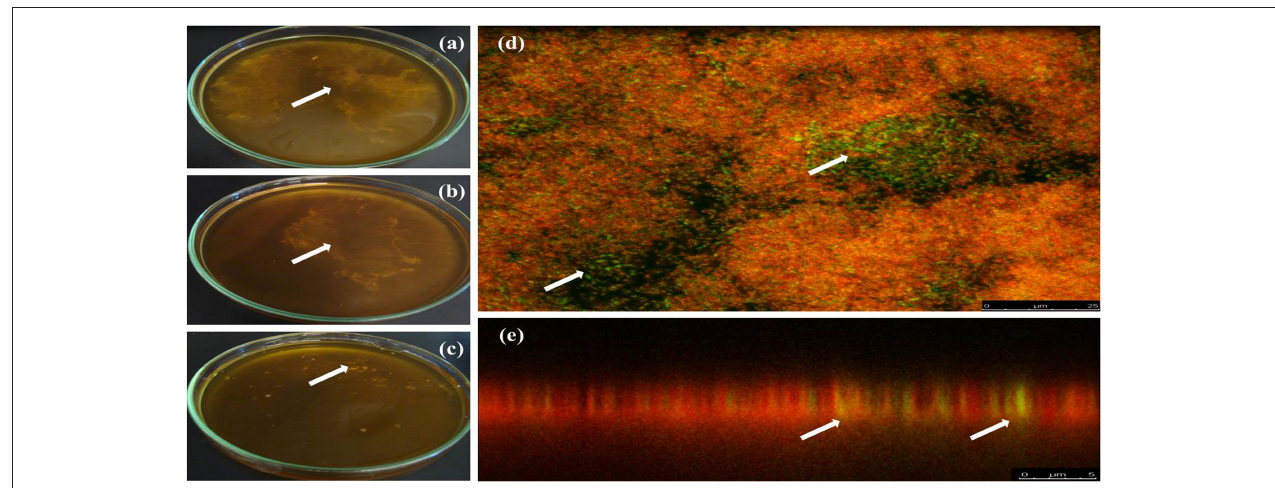
FIGURE 2 | Biofilm formation by positive samples for A. pleuropneumoniae from drinking water. (a–c) Biofilms in the liquid–air interface formed in vitro from drinking water of one Mexican farm in three different samples (arrows show the biofilms). (d,e) FISH technique to detect A. pleuropneumoniae in biofilms from samples of drinking water from swine farms; A. pleuropneumoniae was detected with probes labeled with fluorescein (green) and other bacteria were labeled with ethidium bromide (red) (arrows show A. pleuropneumoniae label). (a,d,e) Ags5-I, (b) Ags5-II, and (c) Ags5-III.